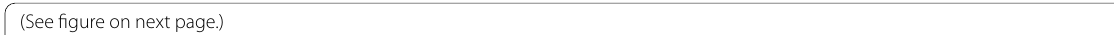
aperture(See figure on next Fig. 10 a The image of the autocorrelation corresponding to the polynomial aperture of the second model or the coherent transfer function (CTF) in the CSLM. b The autocorrelation profile corresponding to the second model of polynomial aperture computed from the FFT technique. c Normalized autocorrelation for the first and second models of polynomial aperture compared with the circular aperture. It is computed from the direct autocorrelation of the